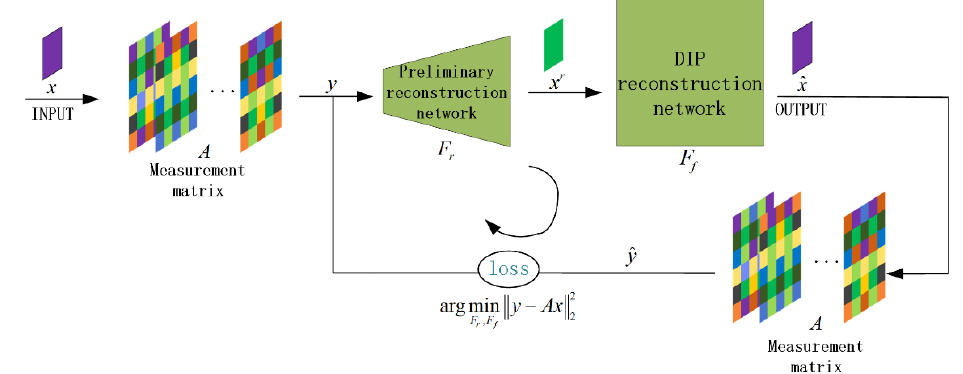
Figure 2. Structure of the proposed CSDIP.